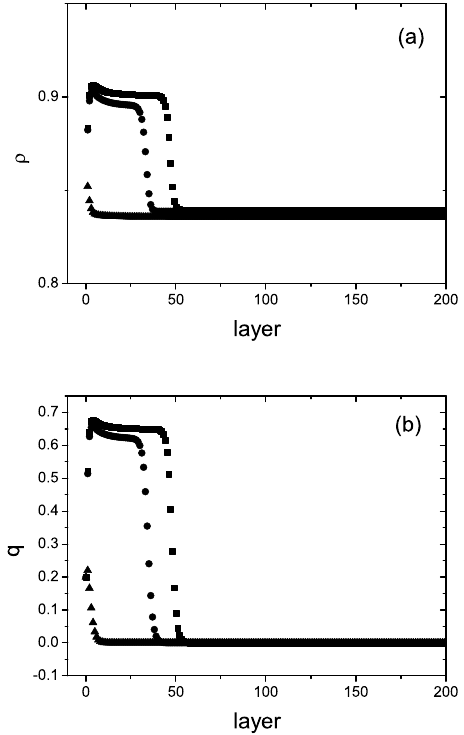
Figure 10. CS case. Profiles for: ( a ) occupancy and ( b ) orientational order parameter. (cid:101) (cid:96) ∼ (cid:96) − 1 ; θ s = 1.69; a = 1.0; squares: θ b = 1.80, circles: θ b = 1.82, and triangles: θ b =